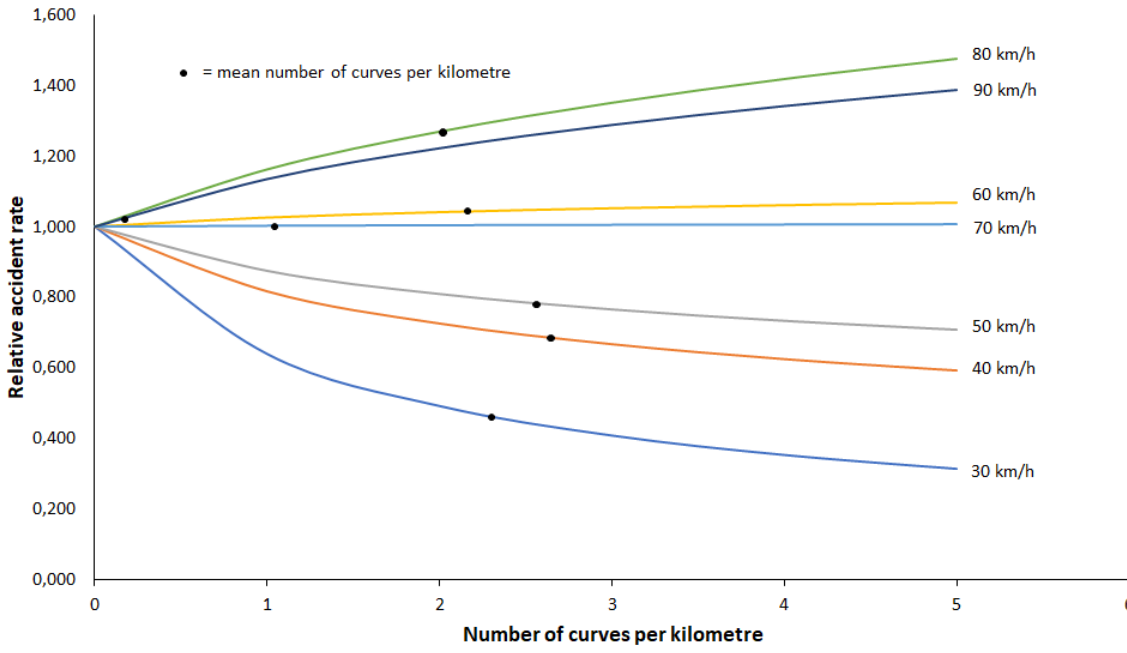
Figure 1 Influence of curves on accident rate on national and county roads in Norway by speed limit. Source : Høye